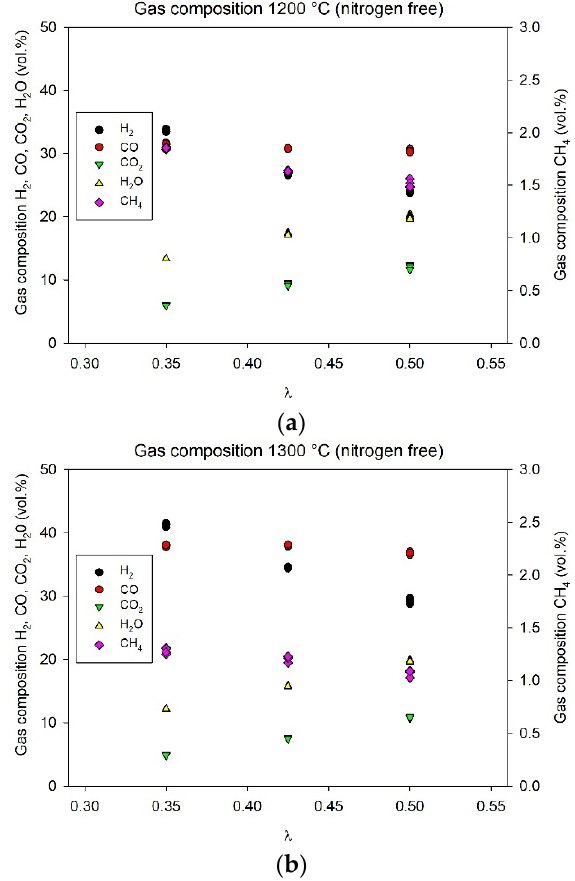
Figure 2. Main gas composition (vol.%) from gasification at ( a ) 1200 °C and ( b ) 1300 °C. Note that the composition is presented as nitrogen free. Table 4. Yield of gas components (mol/kg fuel) from gasification experiments at different operating conditions.